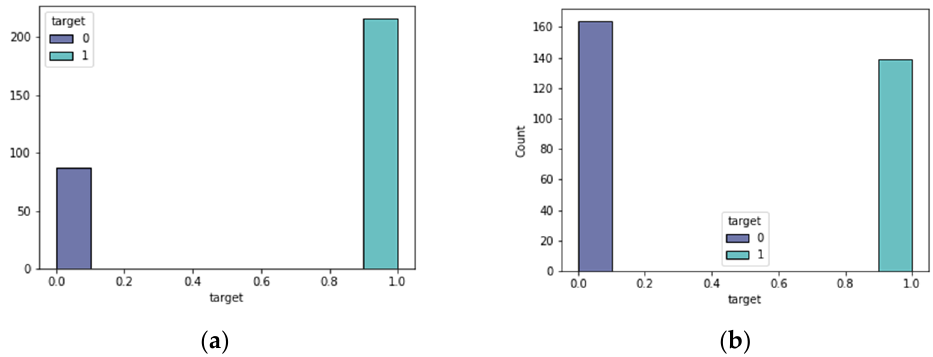
Figure 2. Heart disease classes. ( a ) the Z-Alizadeh Sani dataset; ( b ) the Cleveland dataset.